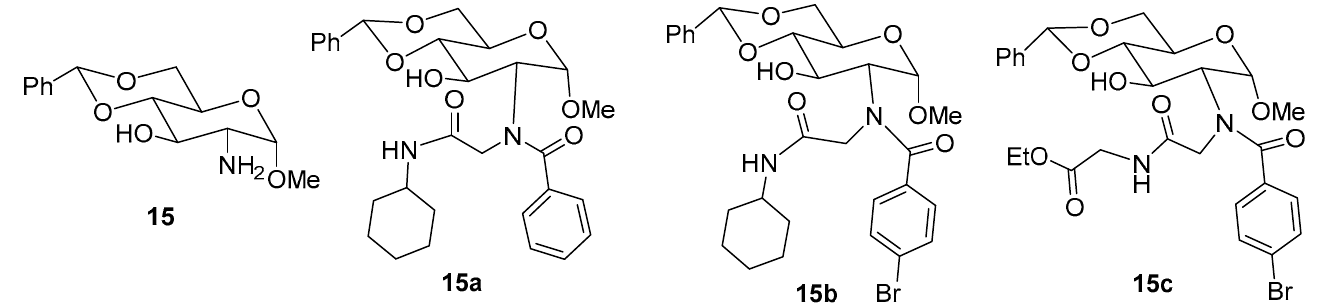
Figure 8. Structure of glucosamine derivative 15 and dipeptoids [37].